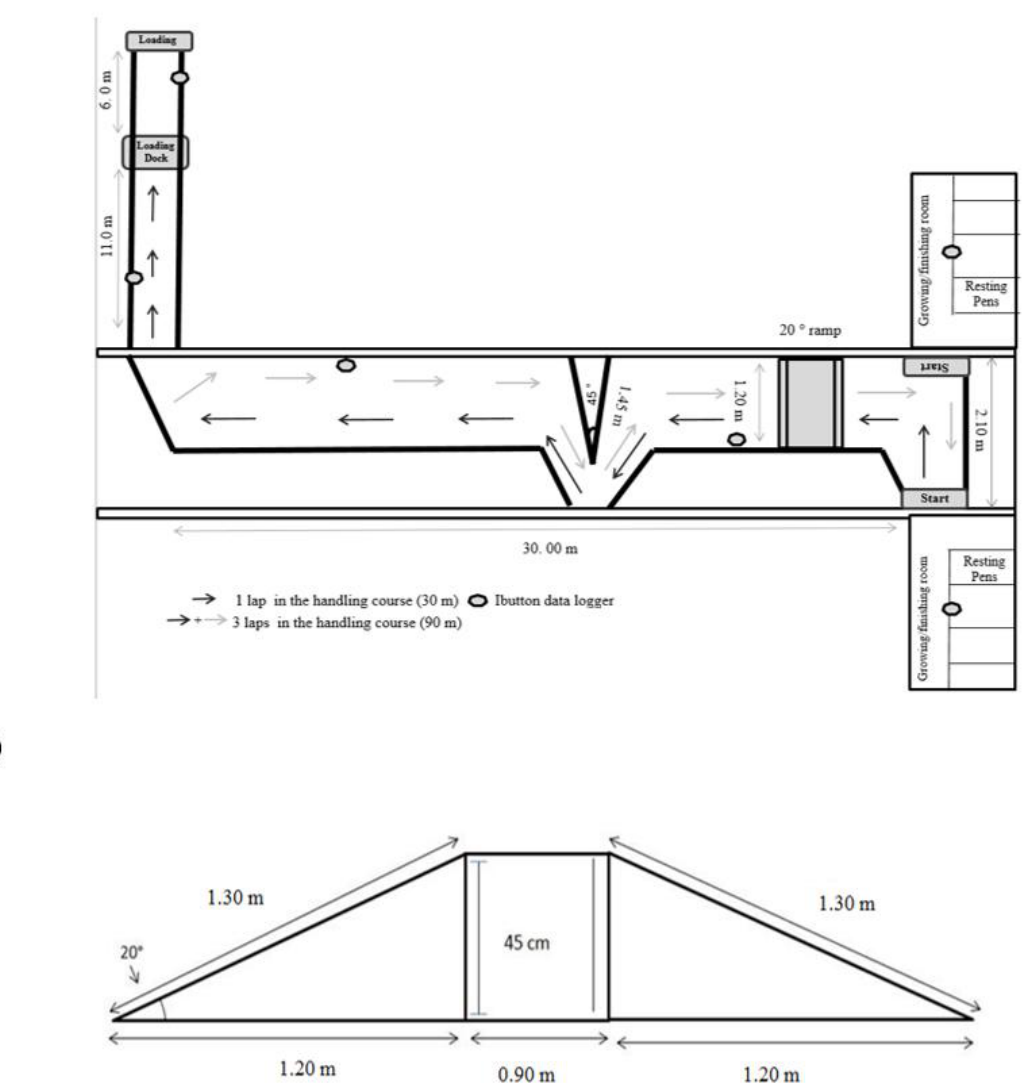
Figure 1. ( a ) Handling stress test course and ( b ) ramp